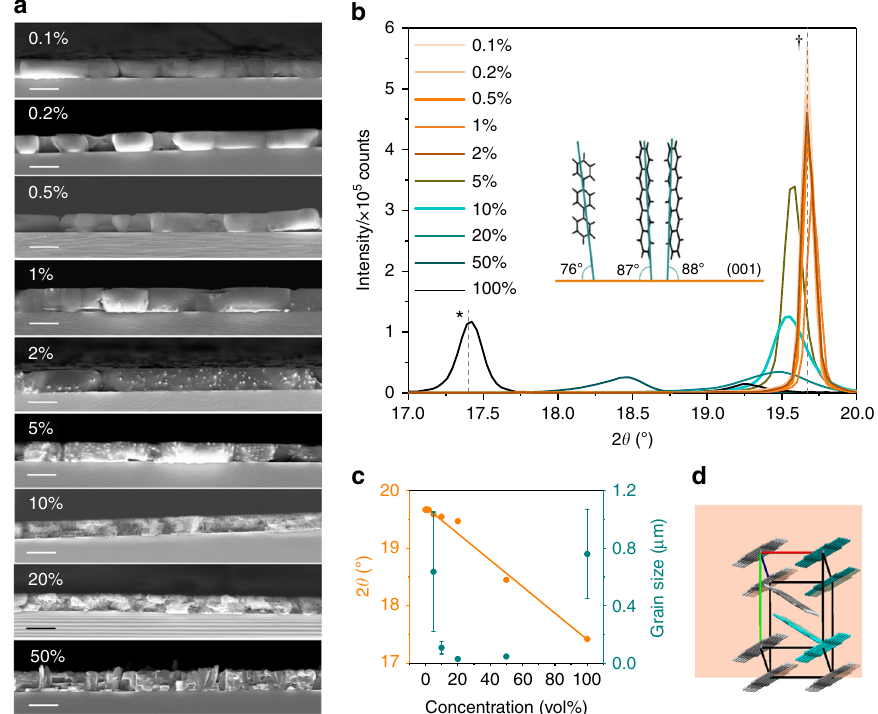
Fig. 2 Morphology and structure of the 1- μ m-thick pentacene fi lms as a function of concentration. a SEM cross-sections with a 1- μ m scale bar. The dilute samples form large platelets typical of p -terphenyl, whereas an increase in dopant concentration leads to fragmentation into smaller faceted grains. b Close-up of the (003) peak where (*) corresponds to the pentacene peak position and ( † ) p -terphenyl position. The inset shows the contact angle of p - terphenyl (left) and pentacene (right) on the substrate. c Variation in scattering angle and grain size (calculated from the Scherrer equation 31 ) with increasing pentacene concentration, indicating a linear shift to towards lower scattering angles (i.e. increased lattice spacing); 5 and 100% pentacene are close to instrument resolution and consequently have the largest error in grain size. All fi lms are 1 μ m except the 100% pentacene which is 100 nm — XRD intensity is normalised to the thickness. The error in crystallite size was estimated as the difference between the Lorentzian and Gaussian calculation of the Scherrer equation. 47 d Unit cell of the pentacene showing the parallel dimer (teal) and herringbone dimer